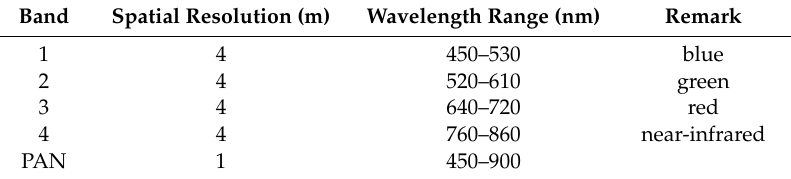
Table 1. Spatial resolution and wavelength range of each band of IKONOS satellite imagery.